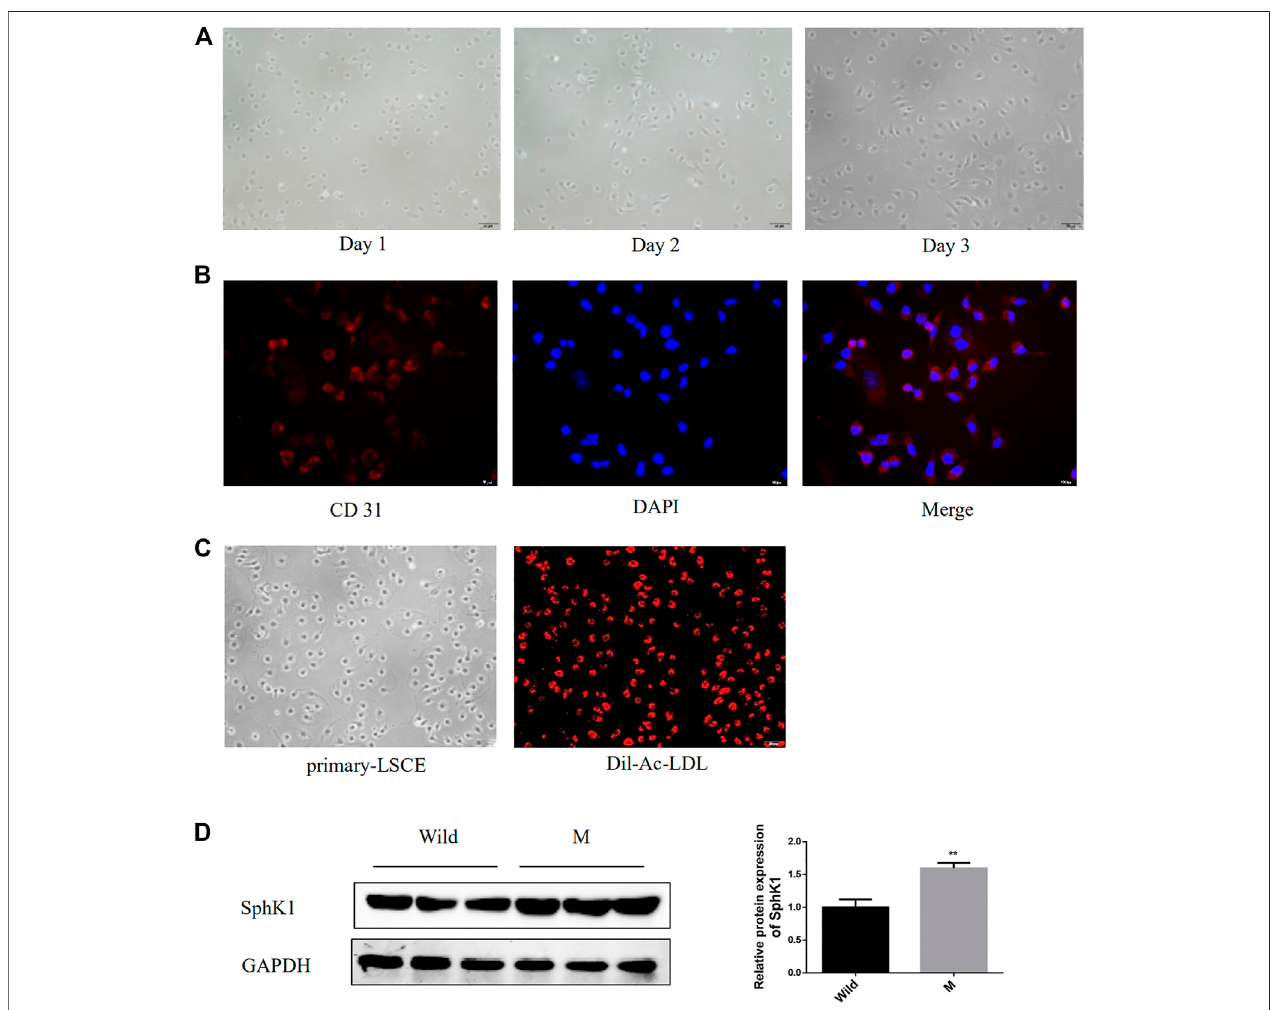
FIGURE 5 | Expression of SphK1 in LSECs isolated from mice with liver fi brosis induced by CCl 4 . (A) : Morphology of isolated mouse primary LSECs. (B) : Isolated mouse primary LSEC could phagocytosis Dil-Ac-LDL. (C) : Isolated mouse primary LSECs expressed CD31. (D) : LSEC of mice with liver fi brosis upregulated the expression of SphK1 ( n (cid:1) 5, ** p < 0.01, vs.